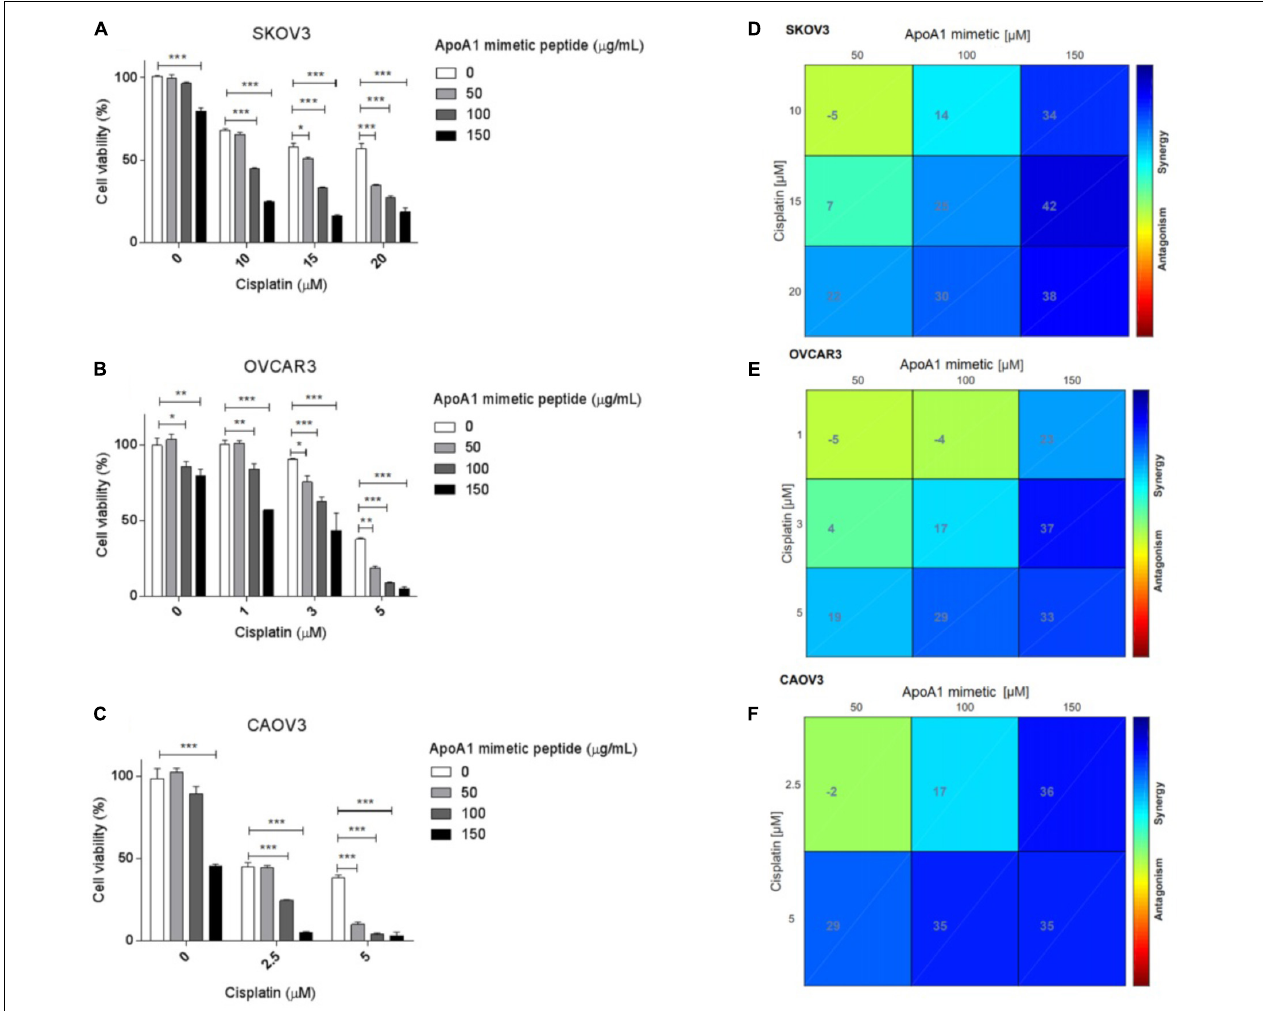
FIGURE 6 | The ApoA1 mimetic peptide sensitizes ovarian cancer cells to cisplatin. SKOV3, OVCAR3, and CAOV3 cells were co-incubated with increasing concentrations of ApoA1 mimetic peptide, up to 150 µ g/mL, and increasing concentrations of cisplatin, according to the sensitivity of each cell line. Exposure to the peptide and cisplatin was performed in full medium conditions. After 72 h, mitochondrial cell viability was assessed. Two-way ANOVA was performed as statistical test (A–C) . ∗ p < 0.05; ∗∗ p < 0.01; ∗∗∗ p < 0.001. Isoboles for assessing synergistic interactions between the ApoA1 mimetic peptide and cisplatin were also plotted (D–F) , according to the Loewe additivity model for synergy/antagonism calculation. On the horizontal axis of the isoboles, the different concentrations of ApoA1 mimetic peptide employed in the in vitro sensitization assay are represented, while in the vertical axis it is represented the concentrations of cisplatin. The intersections represent the combined effect between the peptide and cisplatin. The color gradient ranges from dark blue (strong synergistic effect) to dark red (strong antagonistic effect). From the isoboles analysis, it is possible to identify synergies for different concentrations of ApoA1 mimetic peptide and